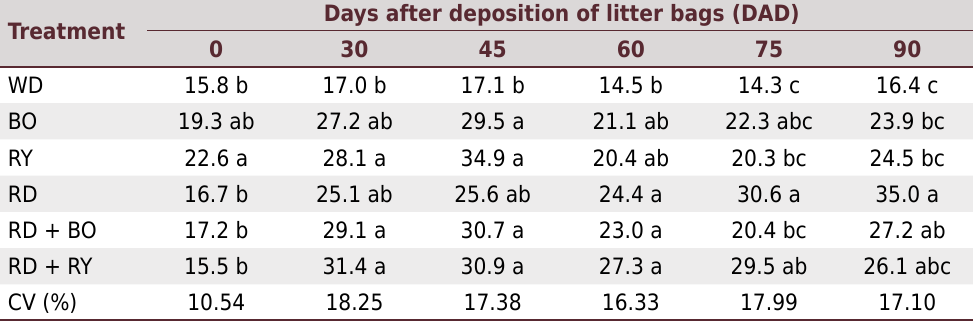
Table 3. Carbon/nitrogen (C/N) ratio of remaining dry matter of the residues of weeds (WD), black oat (BO), rye (RY), oilseed radish (RD), oilseed radish + black oat (RD + BO), and oilseed radish + rye (RD+RY) deposited on the onion